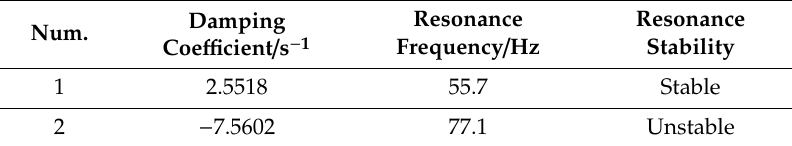
Table 4. Analysis results of resonance modes in wind power bases.